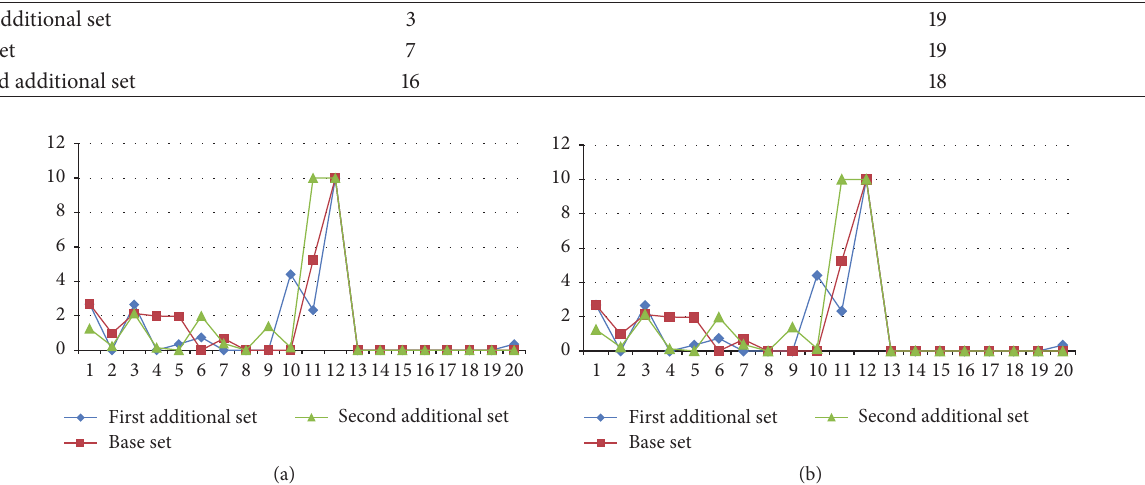
Figure 4: Solving time (seconds) of the instances of the group IV by (a) the CPLEX Solver and (b) the branch and bound